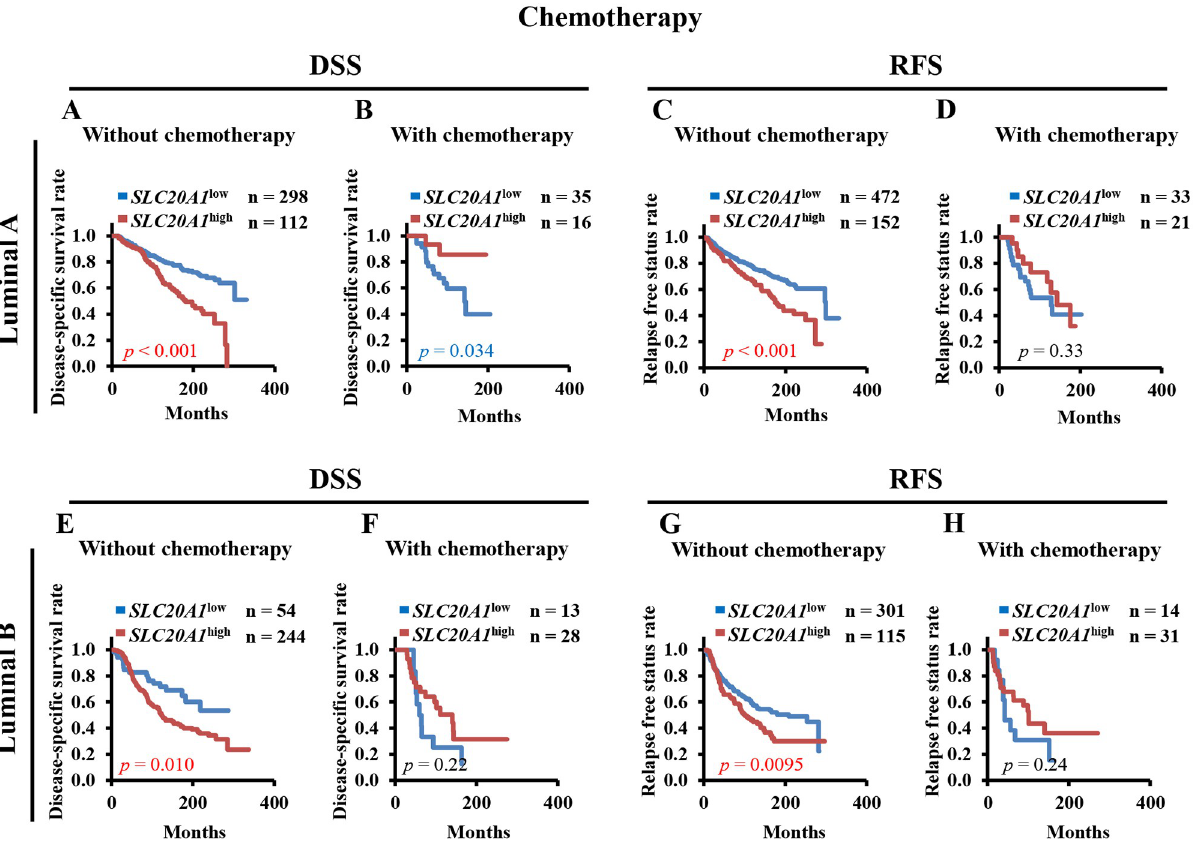
Fig 6. High solute carrier family 20 member 1 (SLC20A1) expression ( SLC20A1 high ) does not confer poor clinical outcomes in the luminal A and luminal B subtypes following chemotherapy. (A-D) Kaplan-Meier analyses comparing disease-specific survival (DSS) and relapse-free status (RFS) between the SLC20A1 high and low SLC20A1 expression ( SLC20A1 low ) groups amongst patients with luminal A breast cancer without or with chemotherapy. (A) DSS in the group without chemotherapy. (B) DSS in the group with chemotherapy. (C) RFS in the group without chemotherapy. (D) RFS in the group with chemotherapy. (E-H) Kaplan-Meier analyses comparing the DSS or RFS between the SLC20A1 high and SLC20A1 low groups amongst patients with luminal B breast cancer without or with chemotherapy. (E) DSS in the group without chemotherapy. (F) DSS in the group with chemotherapy. (G) RFS in the group without chemotherapy. (H) RFS in the group with chemotherapy.